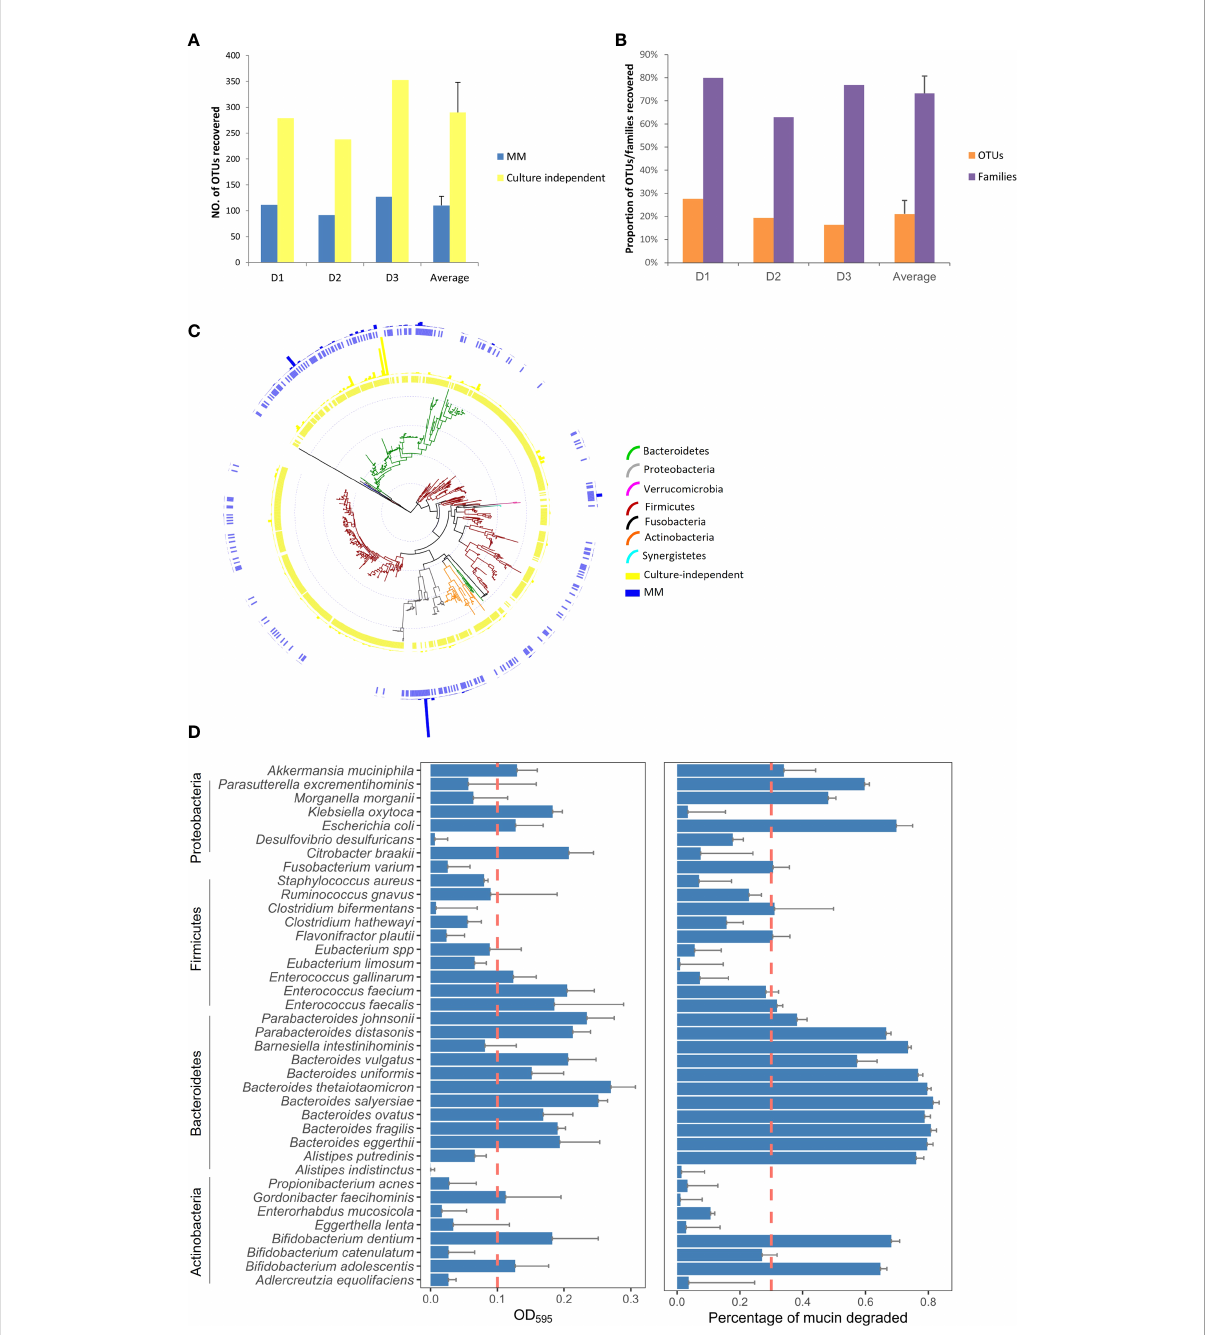
FIGURE 1 Mucin-degrading bacteria captured by cultivation-based molecular pro fi ling. (A) Number of OTUs recovered from 16S rRNA gene sequencing of faecal samples from the three health Donor 1 (D1), Donor 2 (D2) and Donor 3 (D3) by MM media and culture-independent methods. (B) Proportion of OTUs and the corresponding bacterial families from culture MM media as compared to the culture-independent sequencing method. (C) The phylogenetic tree and relative abundance of the OTUs recovered from 16S rRNA gene sequencing of the faecal samples by MM culture and culture-independent methods. The inner ring is colored based on the phylum the OTUs are assigned. The outer ring shows the distribution of OTUs. The exterior bar chart shows the relative abundance of the OTUs. (D) Percentage of mucin degraded over 72 h by the 38 gut isolates in minimal media containing porcine gastric mucin as the sole carbon source. The amount of mucin degraded was measured by the loss of hexose in the supernatant using the anthrone reagent test. Data are means and standard deviations for three